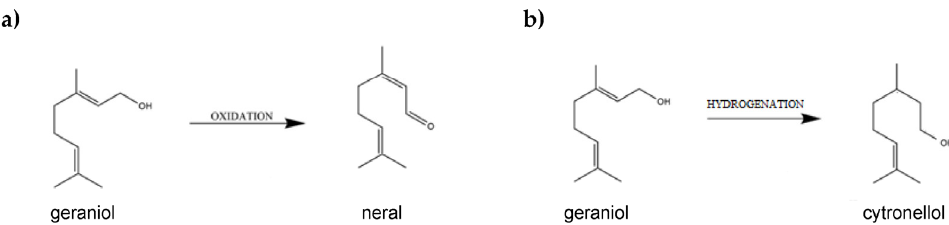
Figure 2. ( a , b ) Diagram of the main chemical reactions occurring during the transformation of geraniol in the presence of garnet.